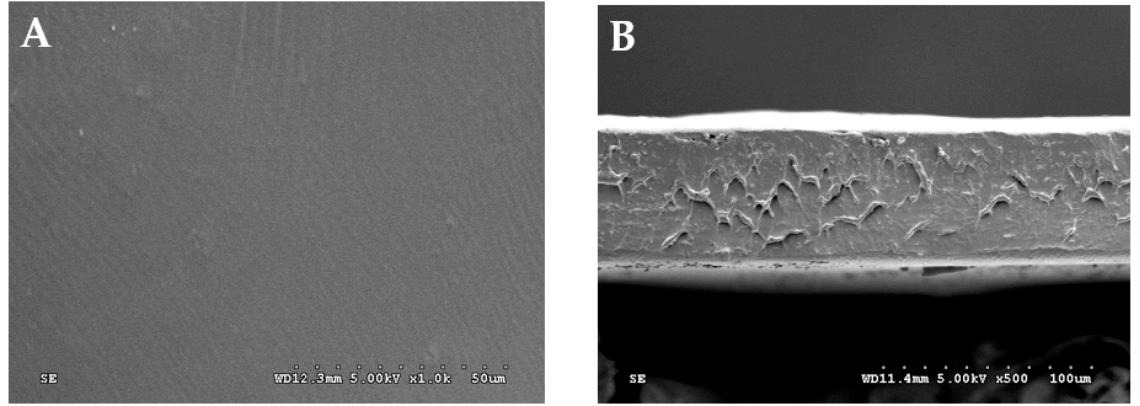
Figure 6. SEM micrograph of surface of taro peel starch, and glycerol blend ‐ based membranes ( A ) film surface at magnification power of 1000×, and ( B ) cross ‐ sectional of films at magnification power of 500×.